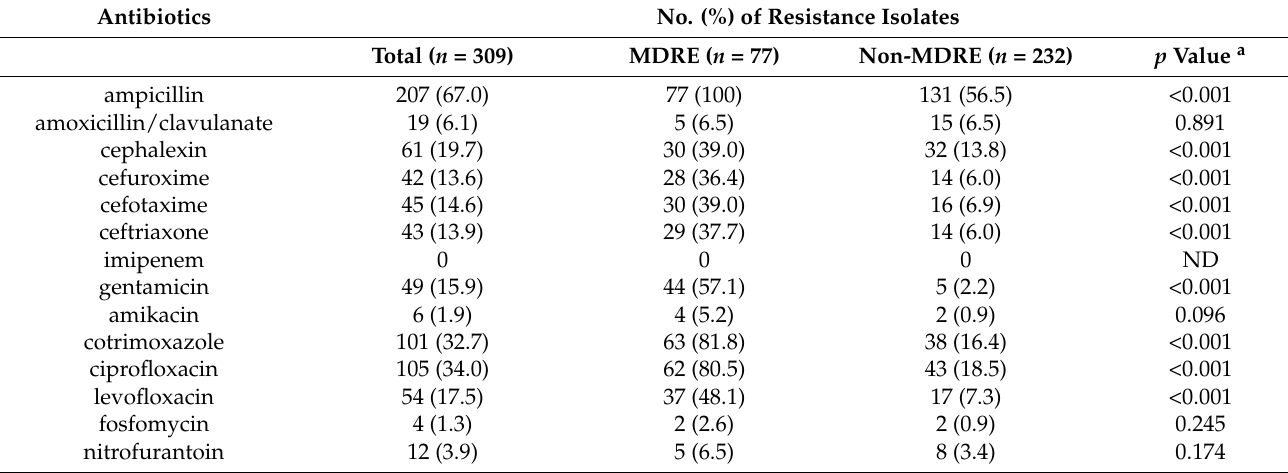
Table 3. Antibiotic resistance rates of MDRE and